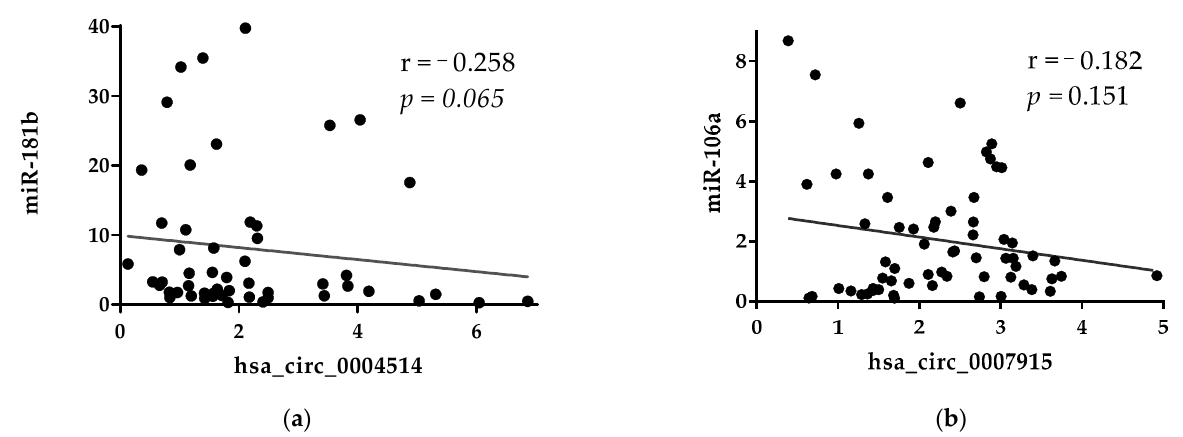
( d ) Figure 5. Comparison between levels of ( a ) miR-181b and ( b ) miR-106a in plasma samples from healthy controls (HC) and patients with CRC in stage IV. The expression levels of both miRNAs were measured using qPCR in plasma from CRC patients and HC. U6 RNA was used as an internal control. Relative gene expression (RE) was calculated using the 2 −∆∆ Ct method. The Mann–Whitney U test was used to compare the two groups—HC and CRC patients; data are presented as mean ±SD. ROC curves of ( c ) miR-181b and ( d ) miR-106a used to differentiate patients with metastatic CRC from HC. We performed a correlation analysis to see whether the levels of miRNAs in plasma would correlate to the levels of circRNAs. No significant correlations were found between